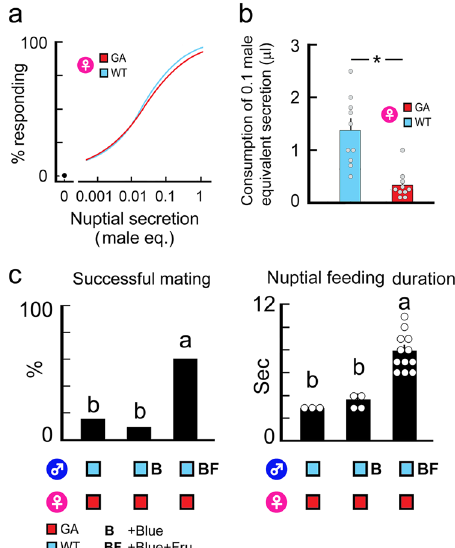
Fig. 2 Mismatch between the quality of male nuptial secretion and female gustatory preferences causes short nuptial feeding bouts and lower mating success in GA females. a Dose-feeding response curves for WT and GA females in response to WT male nuptial secretion represented in male-equivalents ( n = 20 for each). None of the females responded to water (0 male-equivalents, black circle), the vehicle used for nuptial secretion. The EC 50 values (95% CI) (male equivalents (eq.)) were 0.021 (0.015, 0.027) for WT females and 0.026 (0.018, 0.033) for GA females. b Consumption of the WT male nuptial secretion by WT and GA females in a single feeding bout (mean ± SE, n = 10 each). The asterisk indicates a signi fi cant difference ( t = 4.56, P = 0.0002). c Pairing of GA females with intact WT males (Control, n = 20) and with WT males whose nuptial secretion was augmented with blue dye (B, n = 25) or blue dye and fructose (BF, n = 20) (mean ± SE). The addition of fructose to the tergal gland reservoirs of WT males signi fi cantly increased their mating success ( χ 2 (2) = 13.23, P < 0.001). GA females engaged in longer nuptial feeding bouts (nuptial feeding duration) (ANOVA, Tukey ’ s HSD test, F (2, = 23.96, P < 0.0001). Different letters indicate signi fi cant differences 16) among